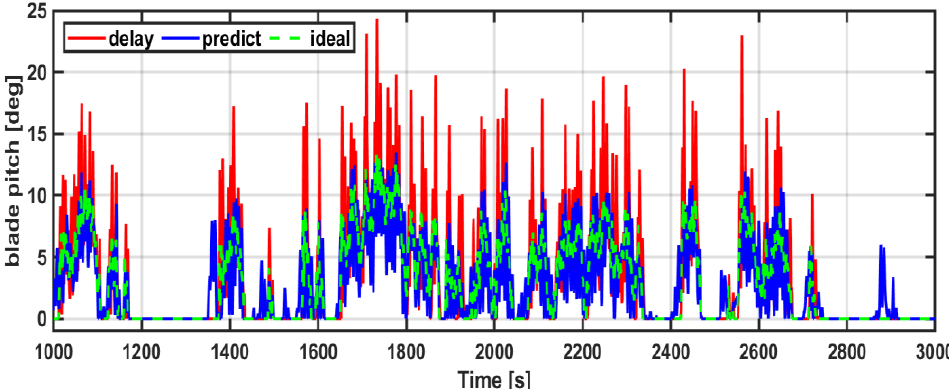
Figure 14. Blade pitch angle of floating offshore wind turbine by pitch controller.